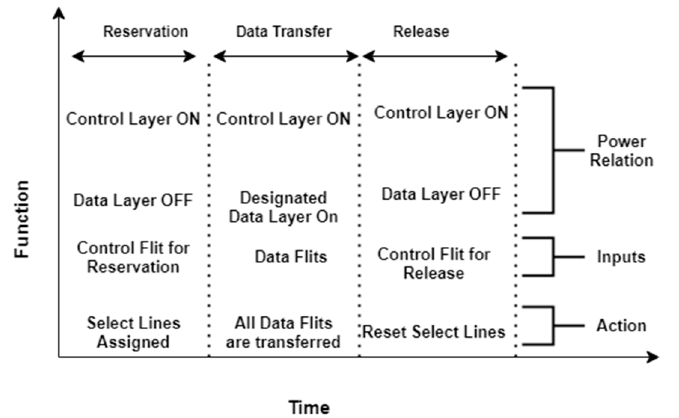
Figure 3. The timing diagram, illustrating the operation of each layer and their sequential relation.